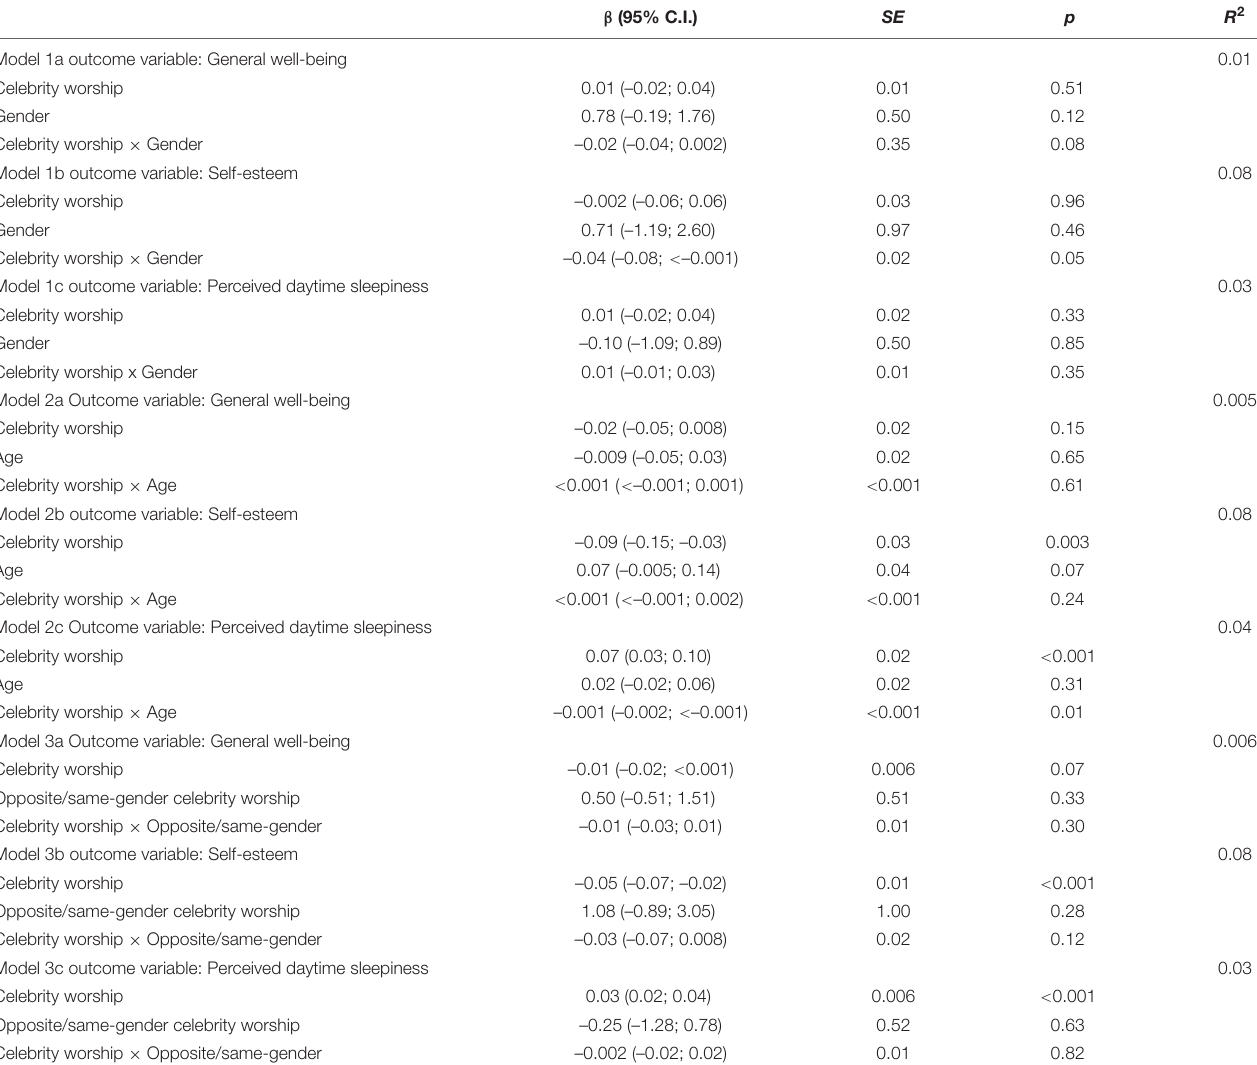
TABLE 5 | Moderation models testing the moderator role of gender, age, and opposite/same-gender celebrity worship on the association between celebrity worship and indicators of subjective well-being.